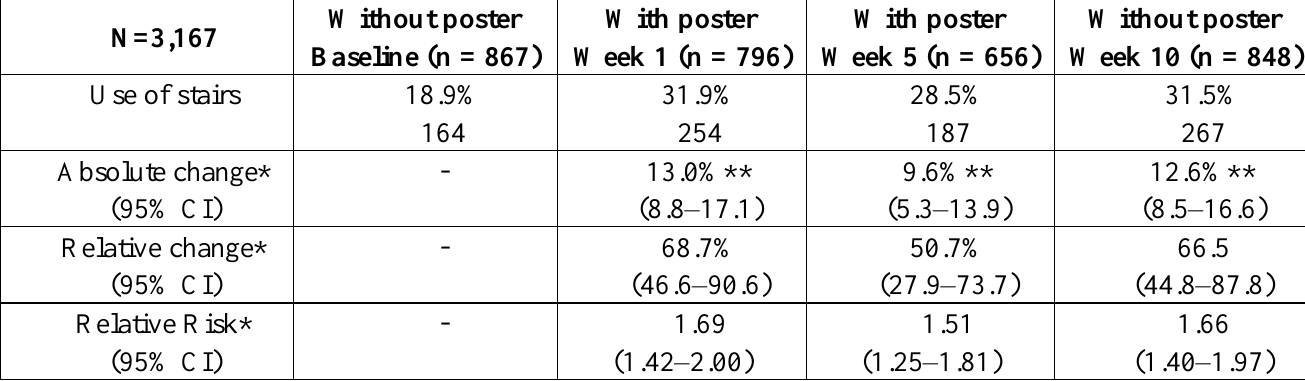
Table 1. Stair use of women at different points in